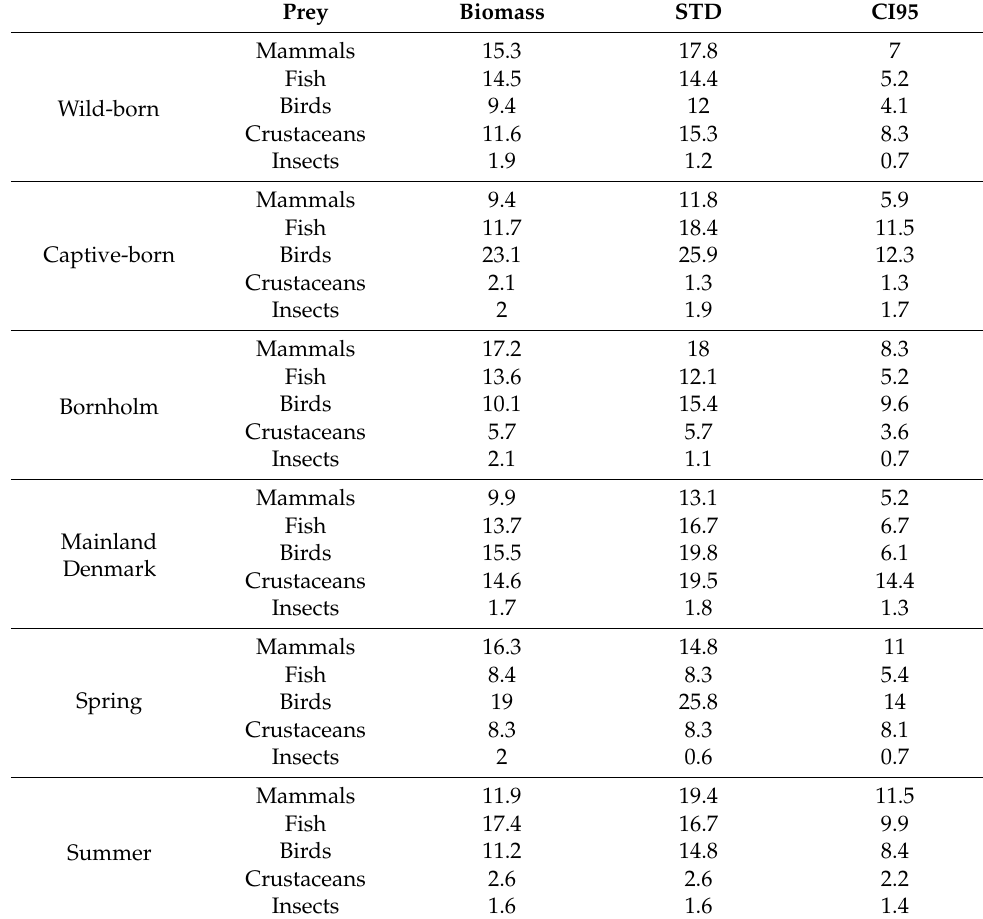
Table A2. The mean biomass with standard deviation ( ± STD) and the 95% confidence intervals (CI95) for the main diet prey categories. The table compares the diet of wild-born and captive-born mink, diet of mink on Bornholm with that of mainland Denmark, and the diet of mink between